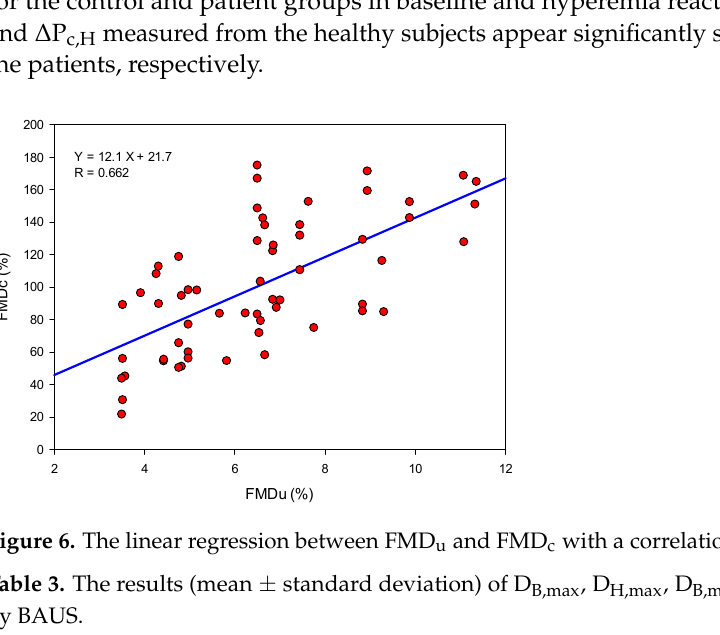
Table 4. The results (mean ± standard deviation) of ∆ P c,B and ∆ P c,H measured by the cuff method.